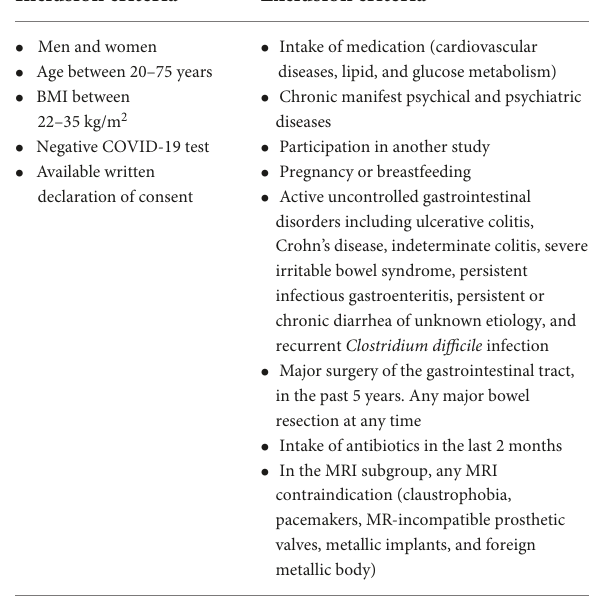
TABLE 1 Eligibility